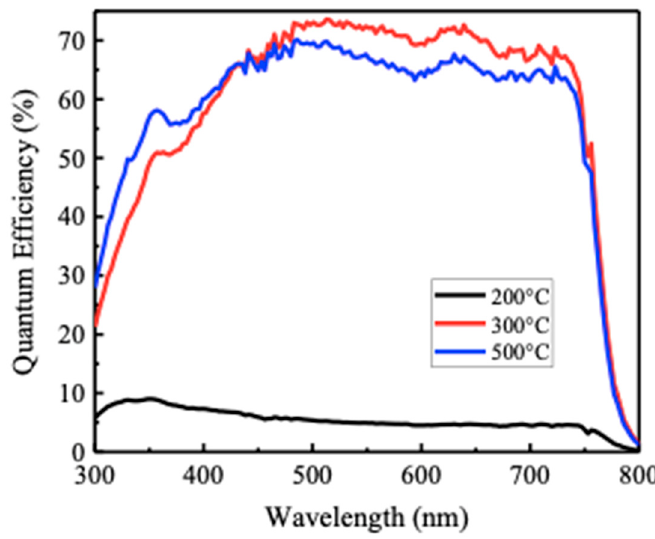
Figure 5. IPCE measurement of the perovskite solar cells equipped with the SnO 2 thin films prepared at various annealing temperature.